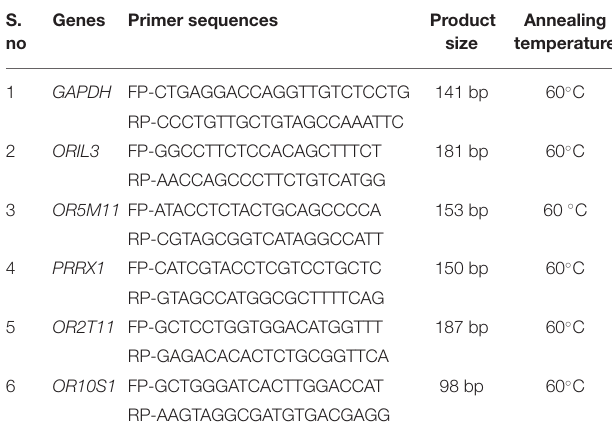
TABLE 1 | Details of primers used for real-time expression